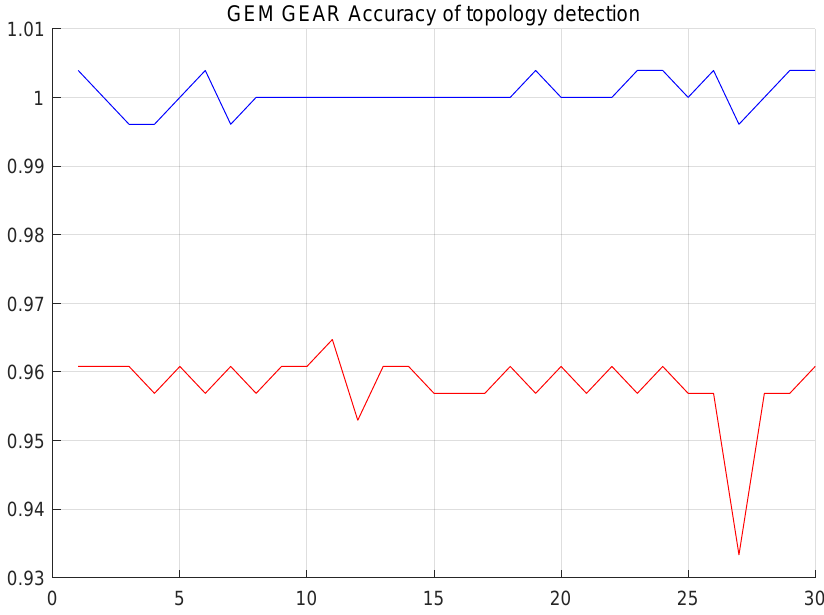
Figure 13. The red lines represent the topology detection accuracy rate of the target network using GEM routing protocol in 30 experiments. The blue lines represent the topology detection accuracy rate of the target network using GEAR routing protocol in 30